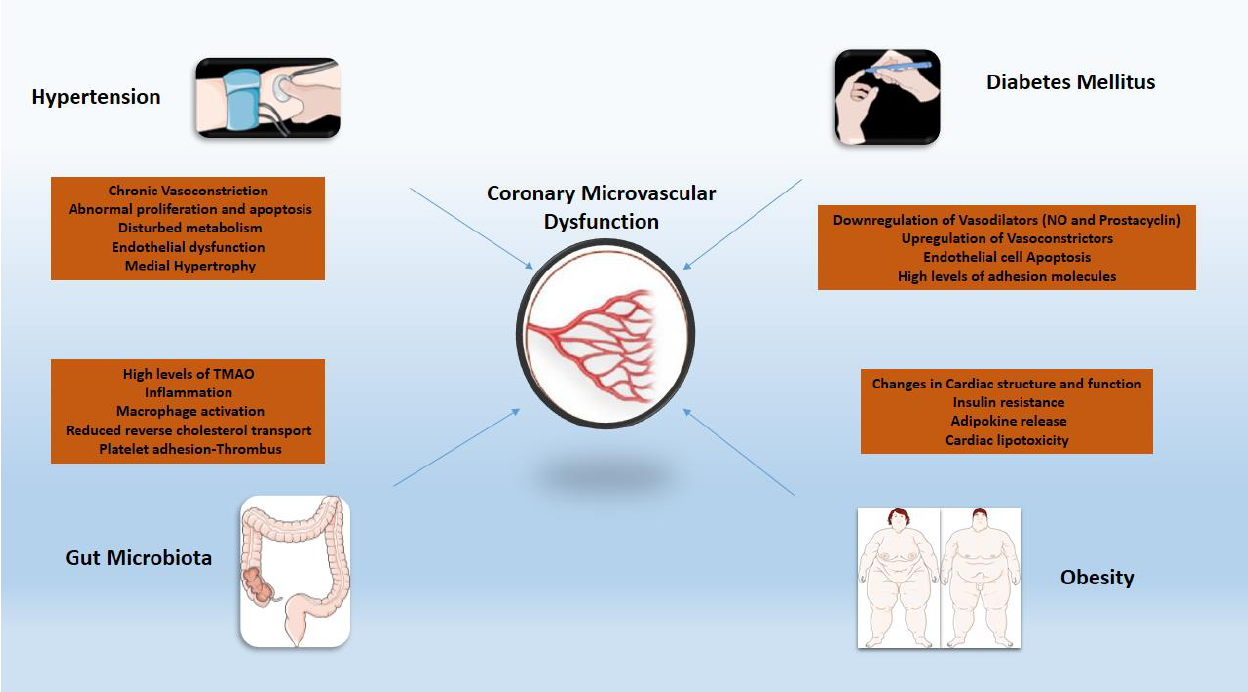
Figure 1. Inflammatory mechanisms of cardiovascular risk factors implicated in coronary microvascular dysfunction. TMAO: trimethylamine N-oxide; NO: nitric oxide.